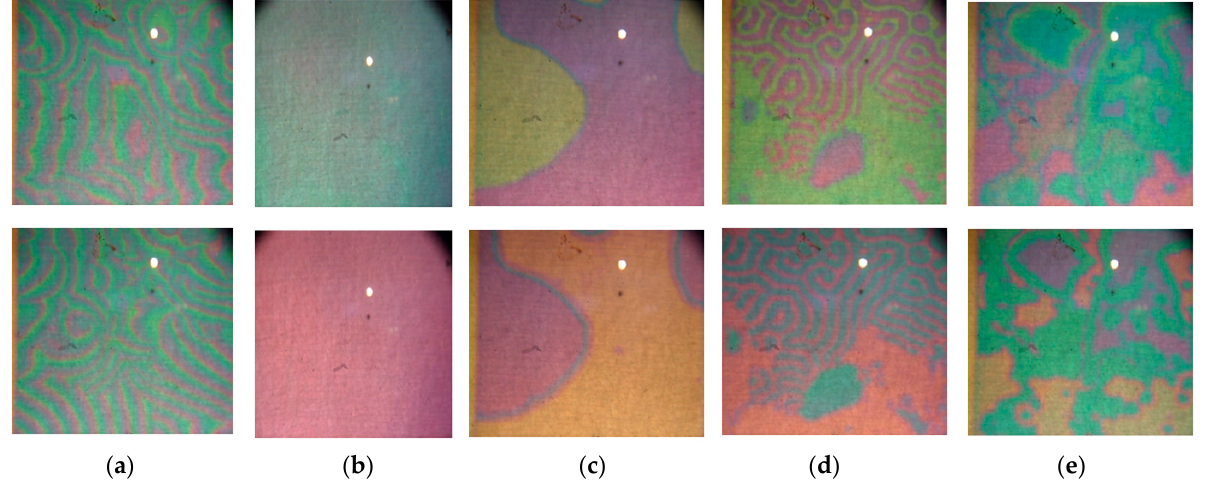
Figure 4. Illustration of various frequency-blocked modes of the AWP in a cell under the influence of a periodic electric force (pulse voltage). Frequency ratios: ( a ) 0, ( b ) 1:1, ( c ) 1:2, ( d ) 1:2.5, and ( e ) 1:3. The exposure times in the upper and lower rows differ by half of a period.